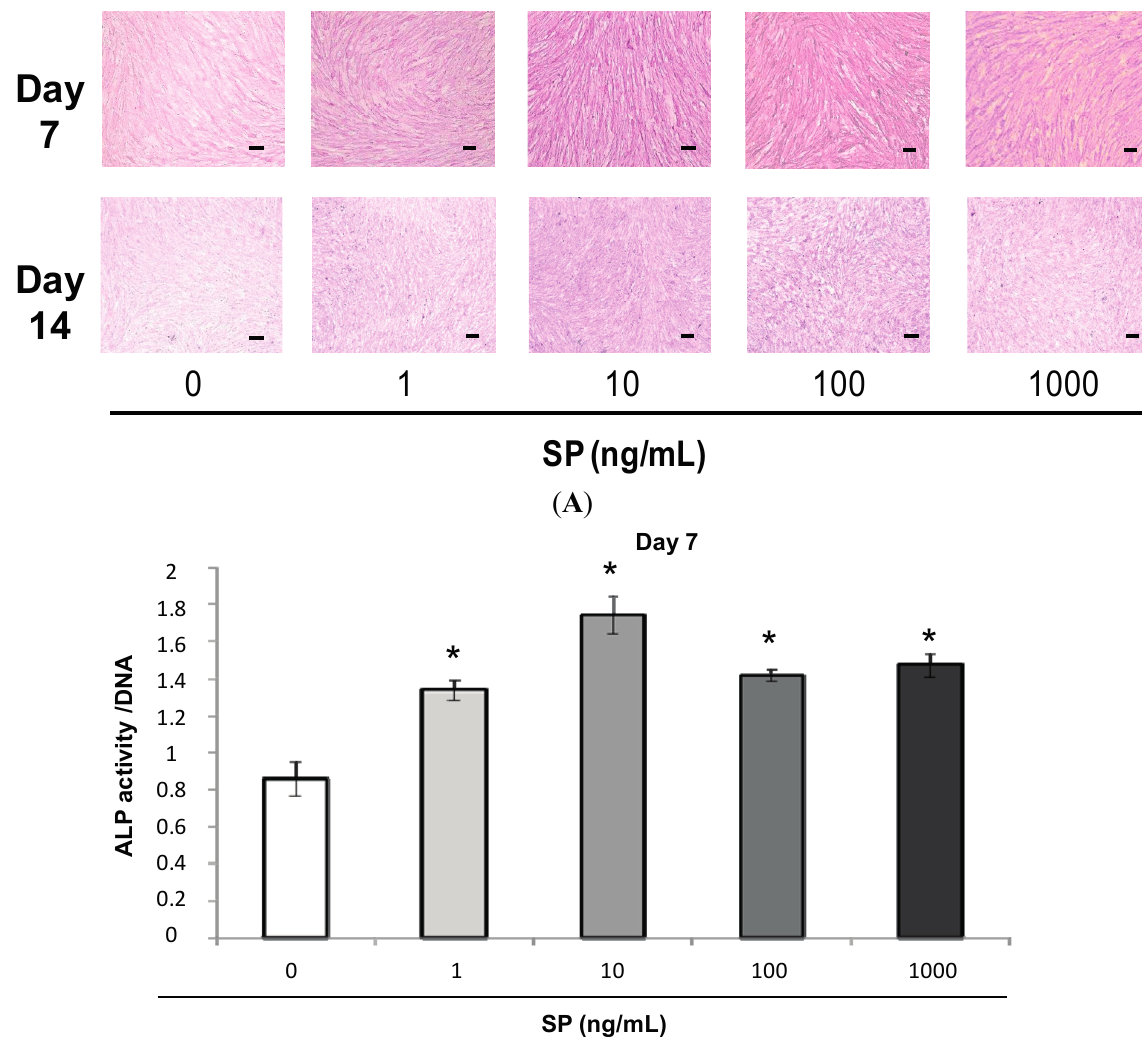
Figure 2. Effect of SP on alkaline phosphatase (ALP) staining and ALP activity. ( A ) Confluent MSCs were stained using an ALP staining kit after 7 or 14 days of cultivation in osteogenic medium containing SP (0, 1, 10, 100 or 1000 ng/mL). Scale bar = 100 μ m; ( B , C ) ALP activity was measured at 7 or 14 days. To normalize ALP activity, the amount of ALP was normalized to the amount of DNA; ( B ) day 7, * p < 0.05 vs. SP (0 ng/mL); and ( C ) day 14, * p < 0.05 vs. SP (0 ng/mL).